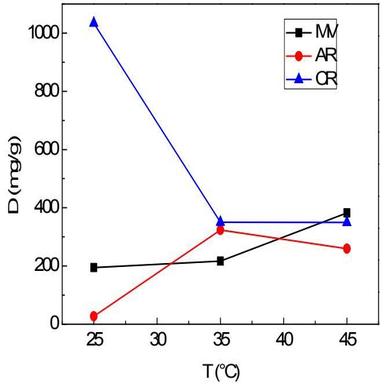
Influence of temperature on the parameter D for the dye adsorption on activated carbon CMCAC at 25–45 ◦C.